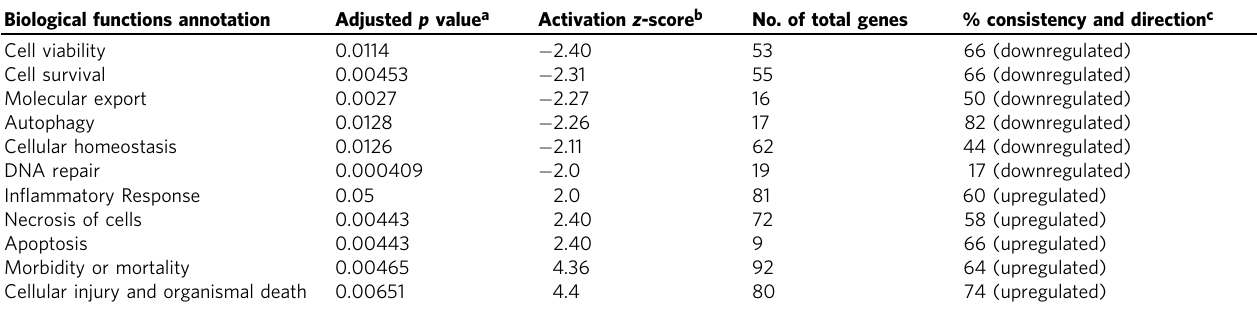
a Compared with Mtb-SC infection data. b z-score is a measure of signi fi cance for the directionality of a biological function/pathway. It is derived from the gene expression pattern. A positive z-score indicates activation/upregulation, and a negative z-score indicates suppression/downregulation of a biological function. c The percentage of total genes with expression consistent with the activation/upregulation or suppression/downregulation of a biological network.